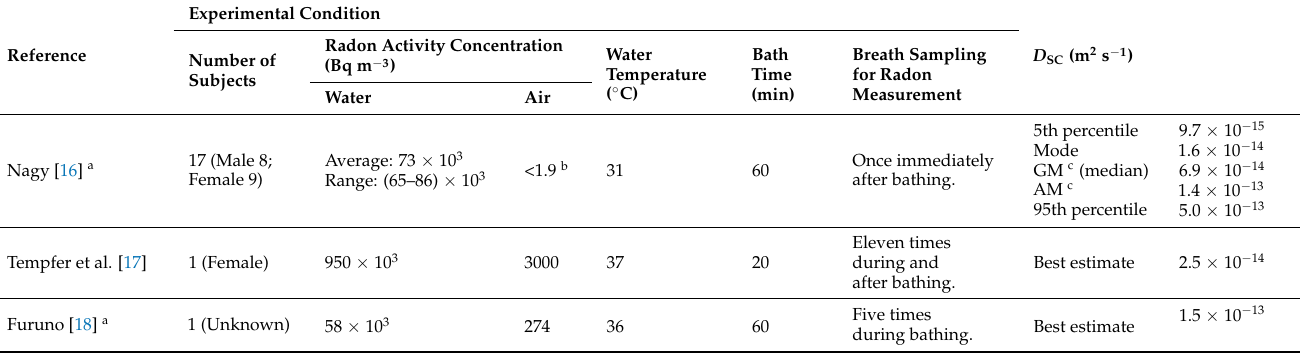
represented here. b Radon-free air was used for breathing. c GM, geometric mean; AM, arithmetic